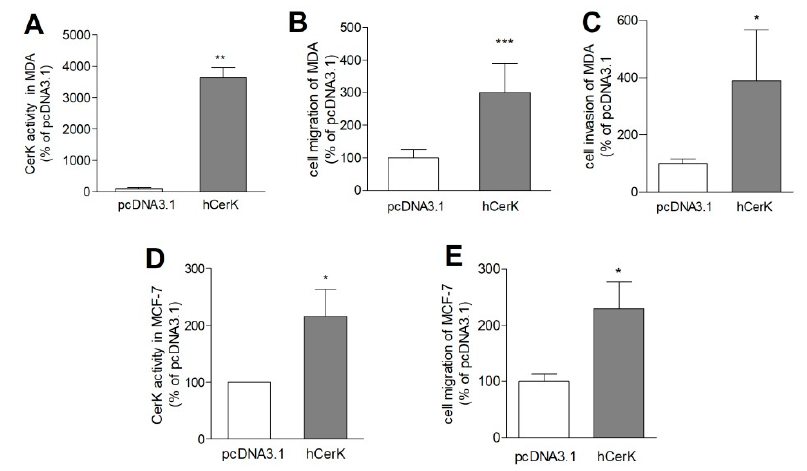
Figure 5. Effect of CerK overexpression on cell migration of parental MDA-MB-231 cells and MCF-7 cells. MDA-MB-231 cells ( A – C ) or MCF-7 cells ( D , E ) were transiently transfected with either an empty vector (pcDNA3.1) or a vector containing the human CerK cDNA (hCerK). 48 h after transfection, cells were examined in a CerK activity assay ( A , D ), in a cell migration assay ( B , E ), or in an invasion assay ( C ), as described in the Methods section. Representative pictures of invaded cells are shown in Supplementary Figure S7. Data are expressed as percentage of pcDNA3.1 controls and are means ± SD ( n = 3). * p < 0.05, ** p < 0.01, *** p < 0.001 compared to pcDNA3.1-treated control cells.